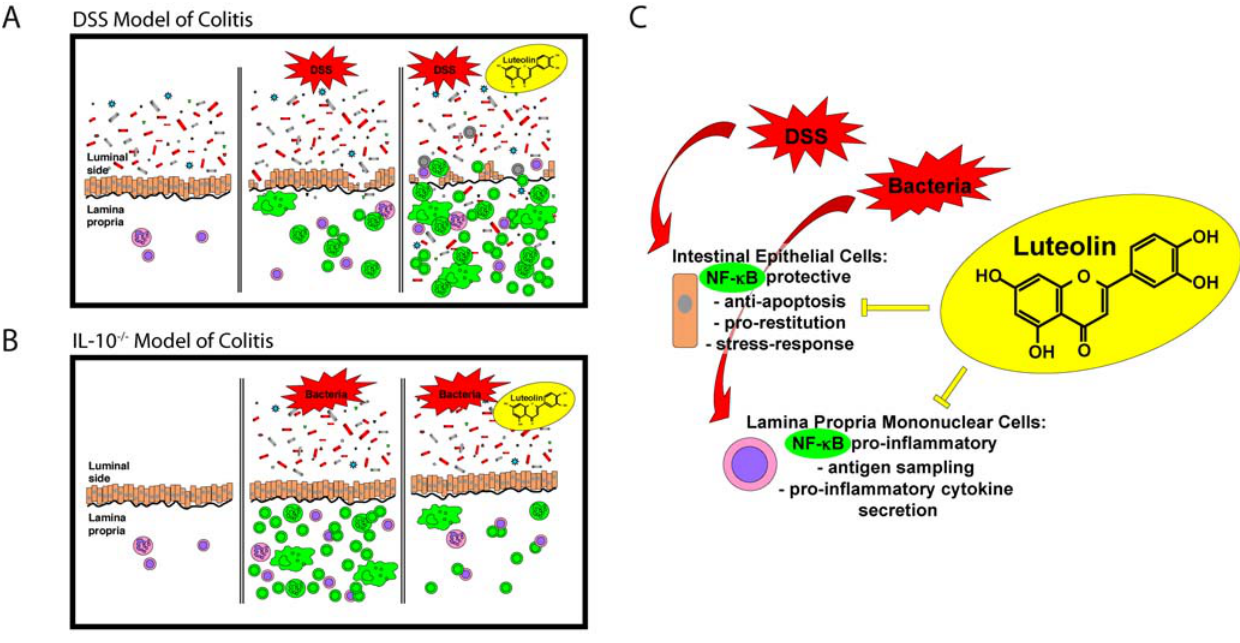
Figure 9. Proposed model for the differential effect of luteolin in DSS-induced acute colitis and in spontaneous chronic colitis in IL-10 2 / 2 -mice. DSS-induced acute colitis in NF- k B EGFP transgenic mice correlates with enhanced EGFP expression (NF- k B activation) in the lamina propria due to the disruption of the epithelial monolayer and the uptake of luminal antigens by lamina propria mononuclear cells (A; middle panel). An impaired epithelial wound-healing response and increased apoptosis in luteolin-fed mice lead to enhanced EGFP expression in lamina propria mononuclear cells and exacerbate DSS-induced colitis (A; right panel). In the context of a primarily intact epithelial layer during colitis in IL-10 2 / 2 ;NF- k B EGFP mice, luteolin decreases bacteria-induced EGFP expression in lamina propria mononuclear cells, which correlates with an attenuation of colitis (B; middle and right panel). Schematic representation of luteolin’s impact on intestinal epithelial cells and lamina propria mononuclear cells: NF- k B activation in intestinal epithelial cells is likely protective (wound-healing response, anti-apoptotis), and its inhibition by luteolin consequently aggravates intestinal damage. As opposed, antigen- (e.g. bacteria-) induced NF- k B activation in lamina propria mononuclear cells leads to NF- k B dependent pro- inflammatory cytokine secretion, thus its inhibition by luteolin likely ameliorates intestinal inflammation